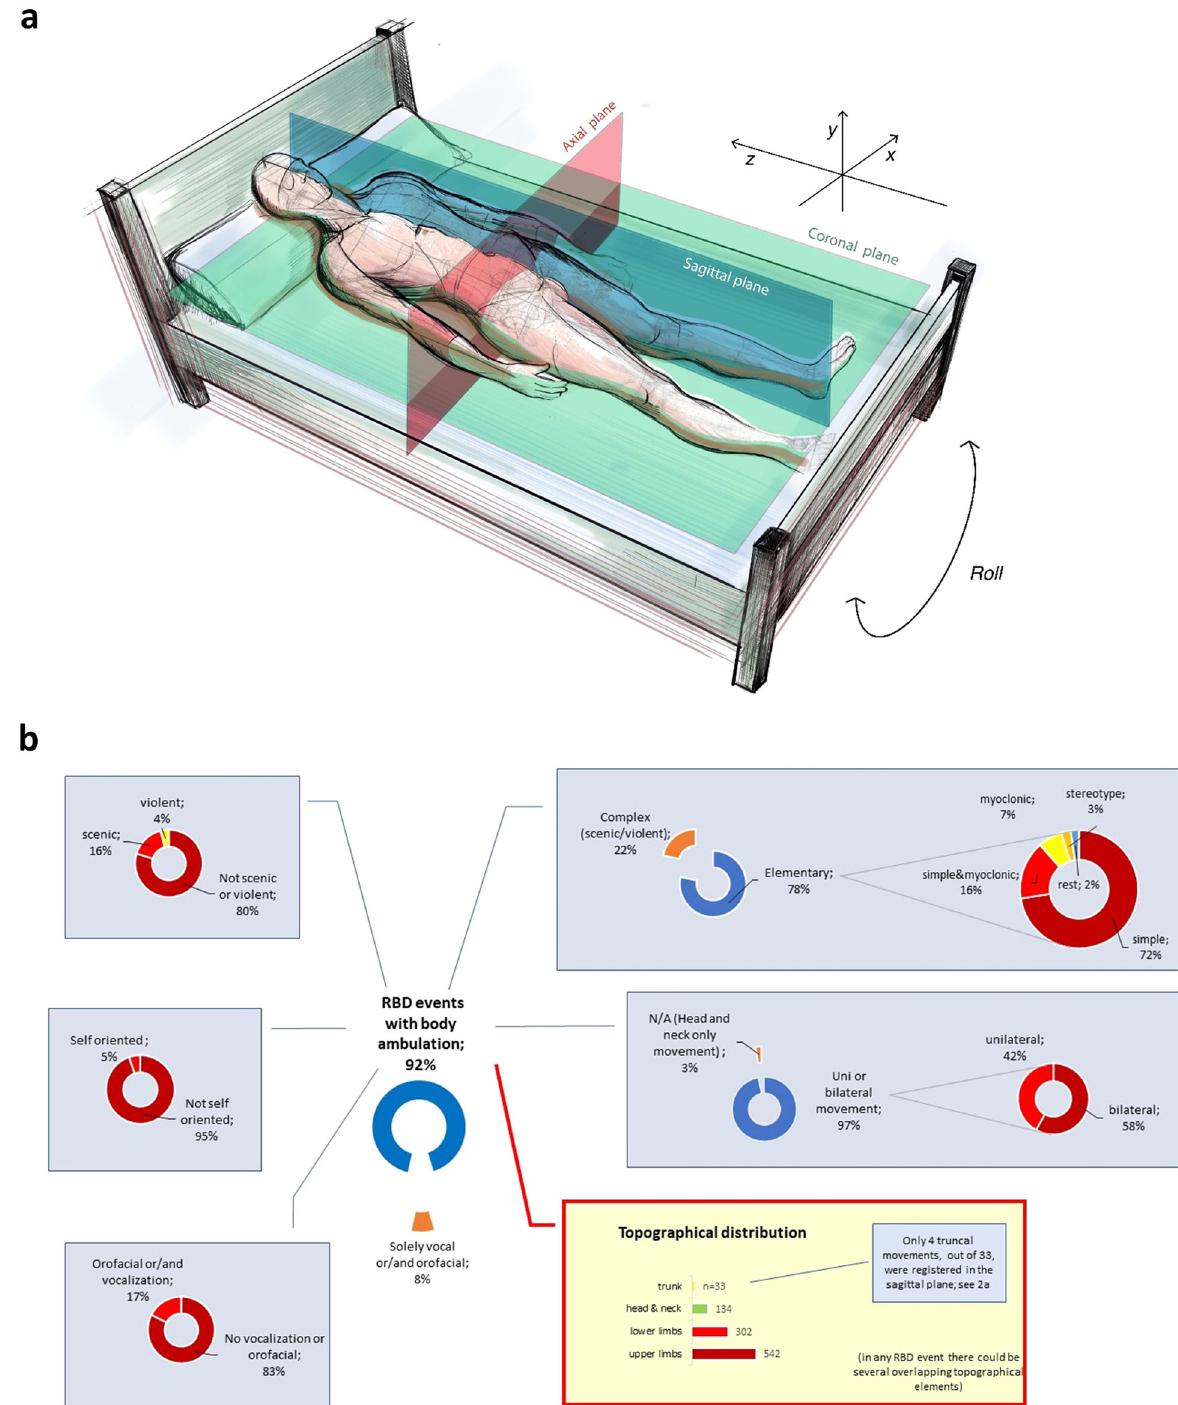
Fig. 1 Schematic presentation of the classi fi cation of the REM-associated motor movements and spatial planes distribution of truncal movements. a Movements were identi fi ed in 675 RBD events, while the remaining 62 were vocalisations or/and orofacial events. Out of 675 analysed movements only four truncal (0.59%) movements were registered across the sagittal plane, perhaps suggestive of predominant allocentric spatial dream navigation ( see text ). The semiology analysis of REM-associated motor movements ( b ) is also shown. They were predominantly elementary ( n = 531), and classi fi ed as simple (72.50%). Dream re-enactment was demonstrated in 20.29% of events; upper (80.30%) and lower limbs (44.74%) were the most frequently involved (orange colour indicates patients that were not included into further categorisation. In elementary movements, the ‘ rest ’ represent one event with both myoclonic and stereotype characteristics, and another one with a mixture of all elementary types. Topographical distribution is visualised via bars since overlapping between several body parts was extensive and did not allow for meaningful grouping as in elementary